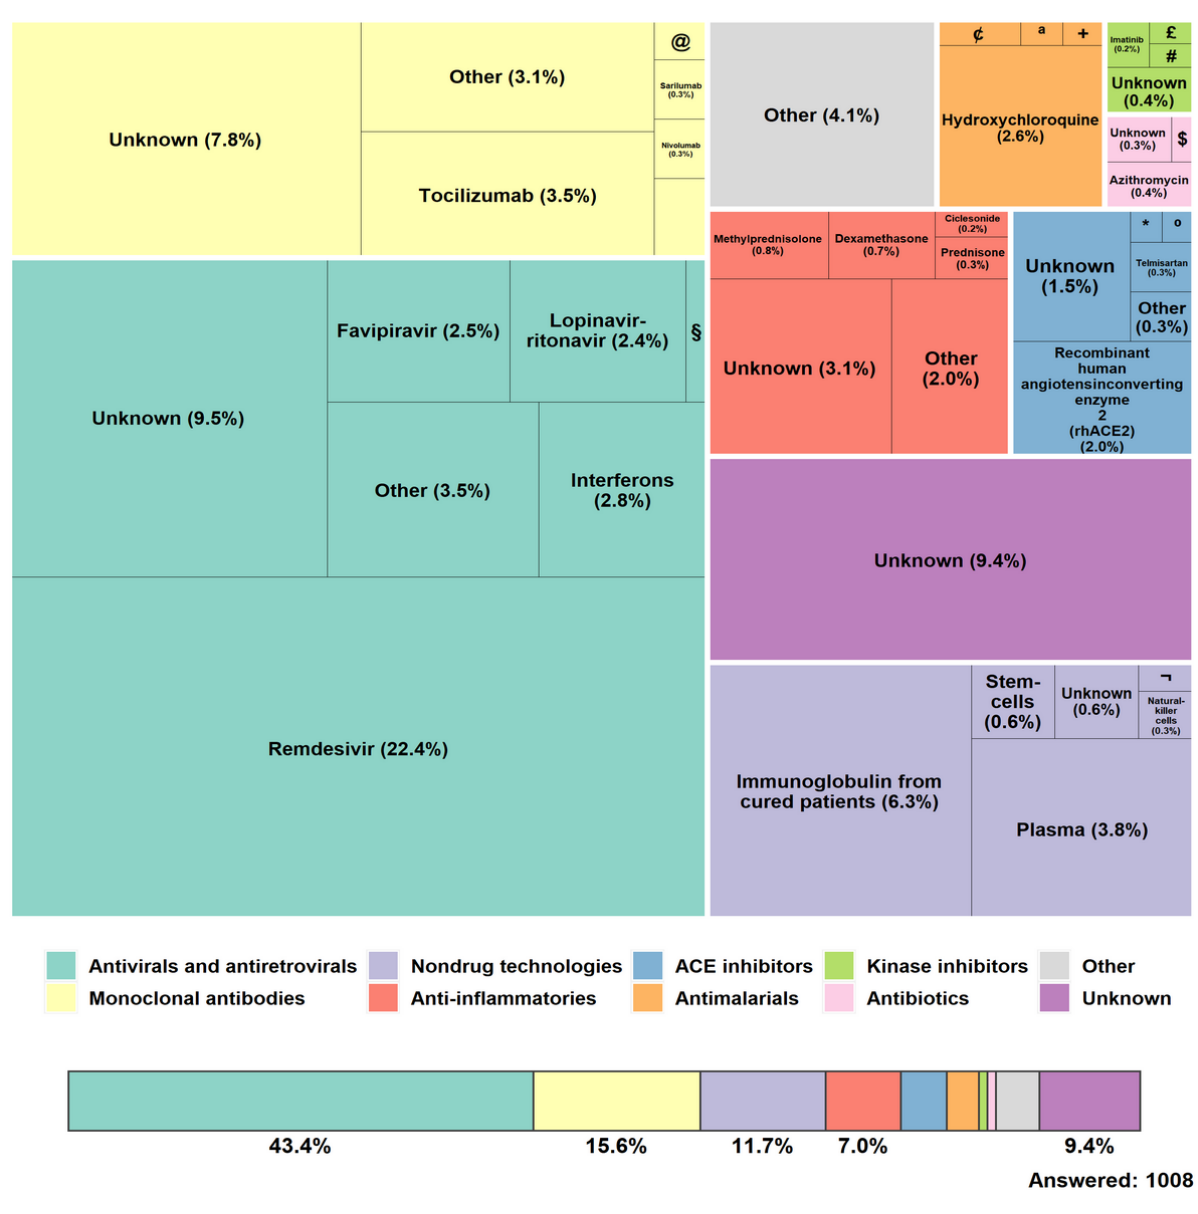
Figure 4. Therapeutics chosen by the respondents to be most likely to succeed in treating COVID-19. § Umifenovir (0.69%); ¢ Unknown antimalarial (0.20%); ª Mefloquine (0.10%); + Chloroquine (0.10%); $ Other antibiotic (0.10%); * Losartan (0.10%); º Captopril (0.10%); @ Bevacizumab (0.20%); £ Acalabrutinib (0.10%); # Other kinase inhibitor (0.10%); ¬ Other nondrug